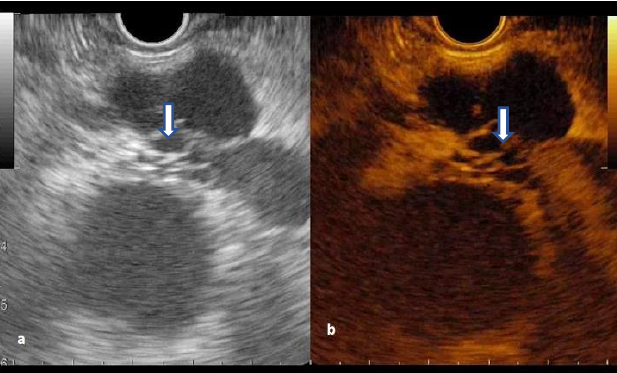
Figure 3. Serous cystic neoplasm with honeycomb appearance (arrow): ( a ) B-mode EUS; ( b ) Contrast-enhanced EUS.